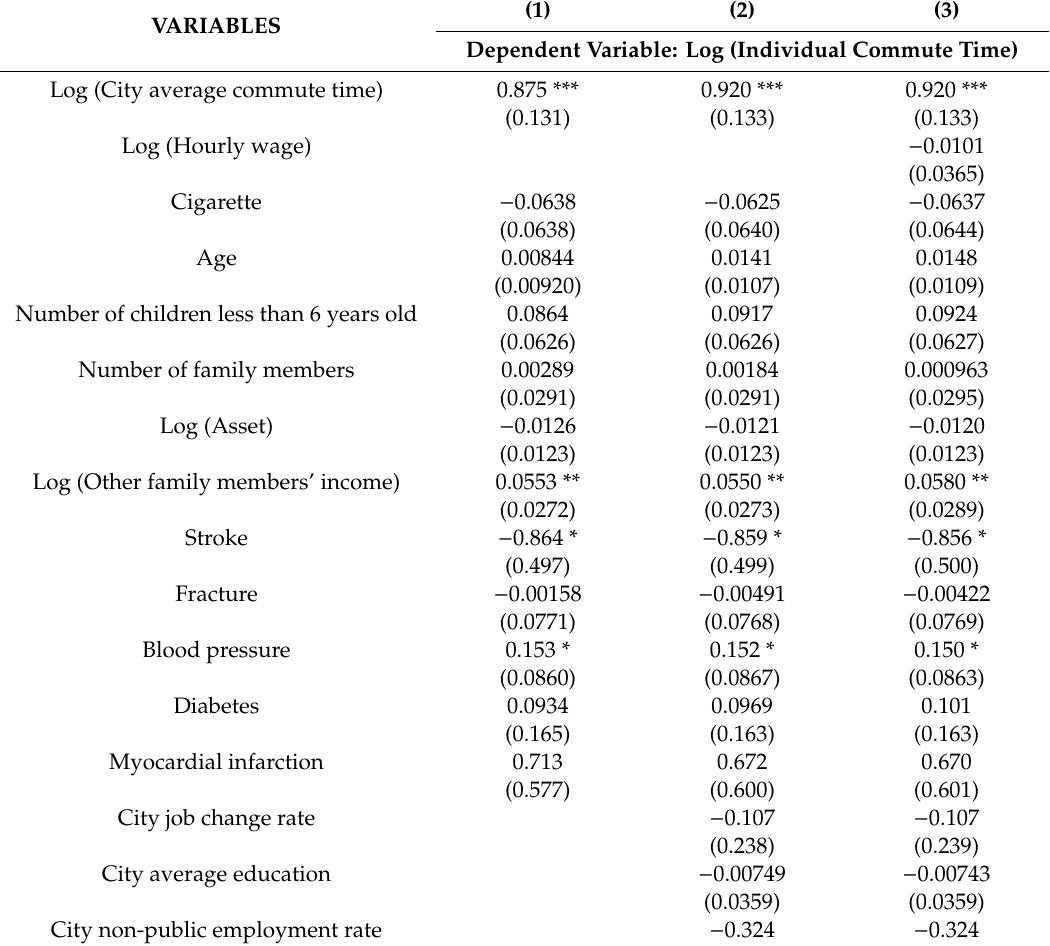
Table 2. E ff ect of city average commute time on individual commute